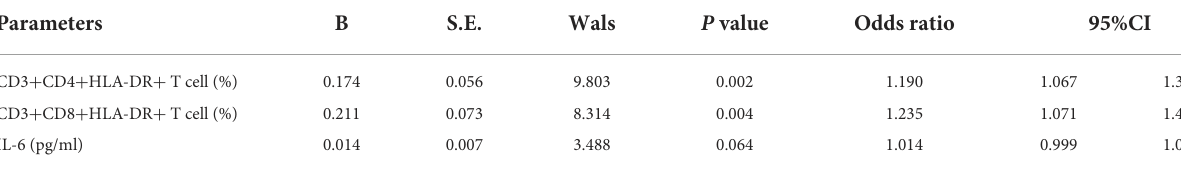
TABLE 3 Logistic regression analysis for identifying independent indicator associated with complete remission in